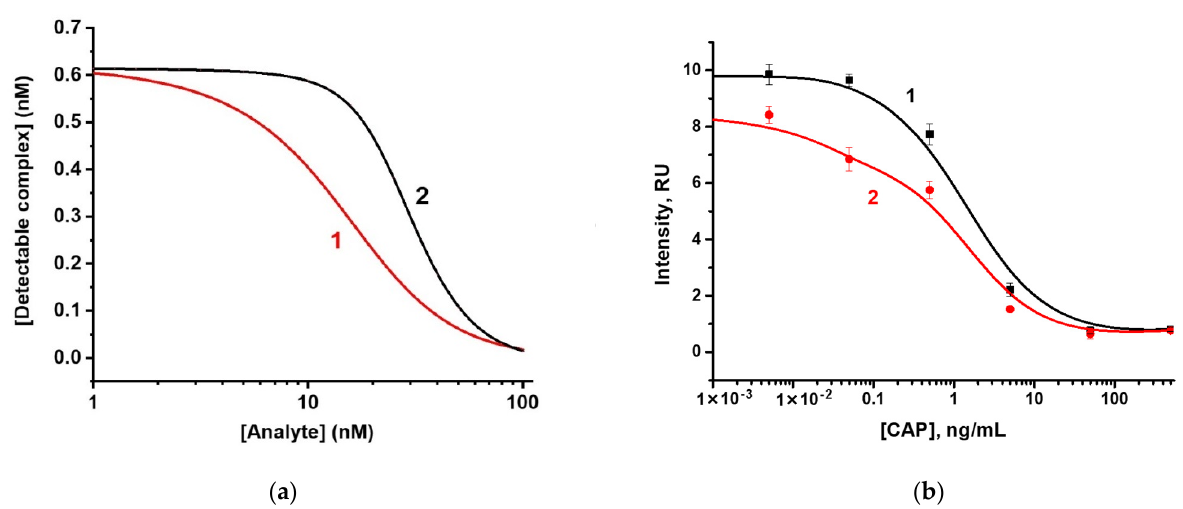
Figure 2. Dependence of the concentration of the detected complex in the absence of the analyte in (1) the proposed double competitive LFIA and (2) standard competitive LFIA. Model parameters: T = 30 s; t = 300 s; k ai = 10 6 1/(M × s); k di = 10 − 4 1/s.; [A] 0 = 0 M. 1—[C] 0 = 10 nM; [R] 0 = 1 nM; 2—[R] 0 = 6.2 nM.